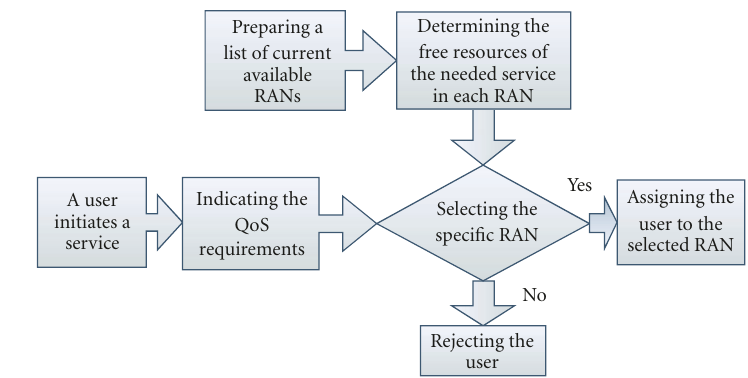
Figure 4: Assigning the user to the suitable